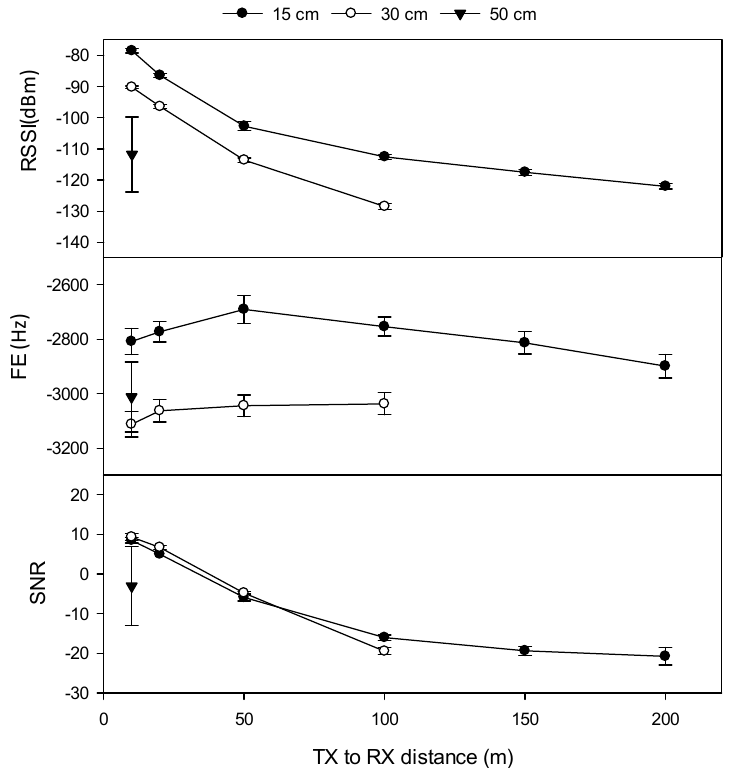
Figure 7. Effect of TX burial depth (cm) on transmission distance and quality at Site 1b (Rudosol) (0.2 kbps data rate, TX power +23 dBm, 1/14 λ TX antenna, 1/3 λ RX antenna). RSSI (dBm) refers to received